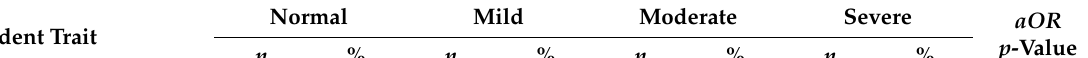
Table 4. Severity of dry eye, according to the OSDI, in the study participants by selected behavioral and environmental factors ( n = 312).